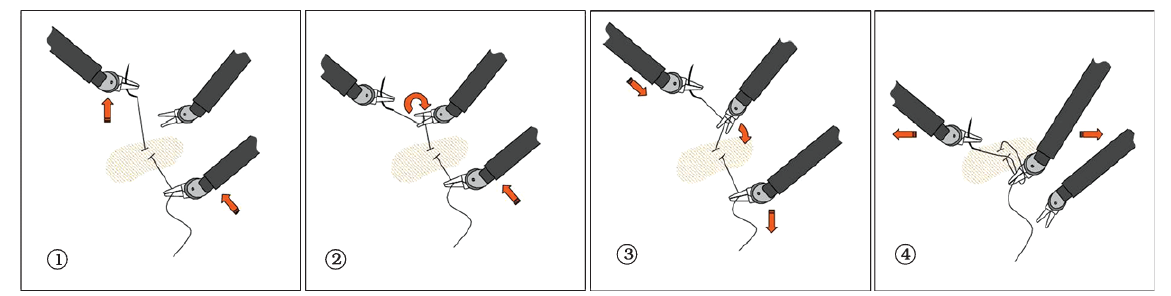
Fig. 2. Knot-tying procedure: After piercing, the needle with the thread is pulled out of the tissue with the left gripper (1) and wound about the right gripper (2). During this procedure, the loose end of the thread is retained by an assistant. This facilitates grasping of the end by the right gripper (3). Finally, the end of the thread is pulled through the loop around the right gripper in order to finalize the knot